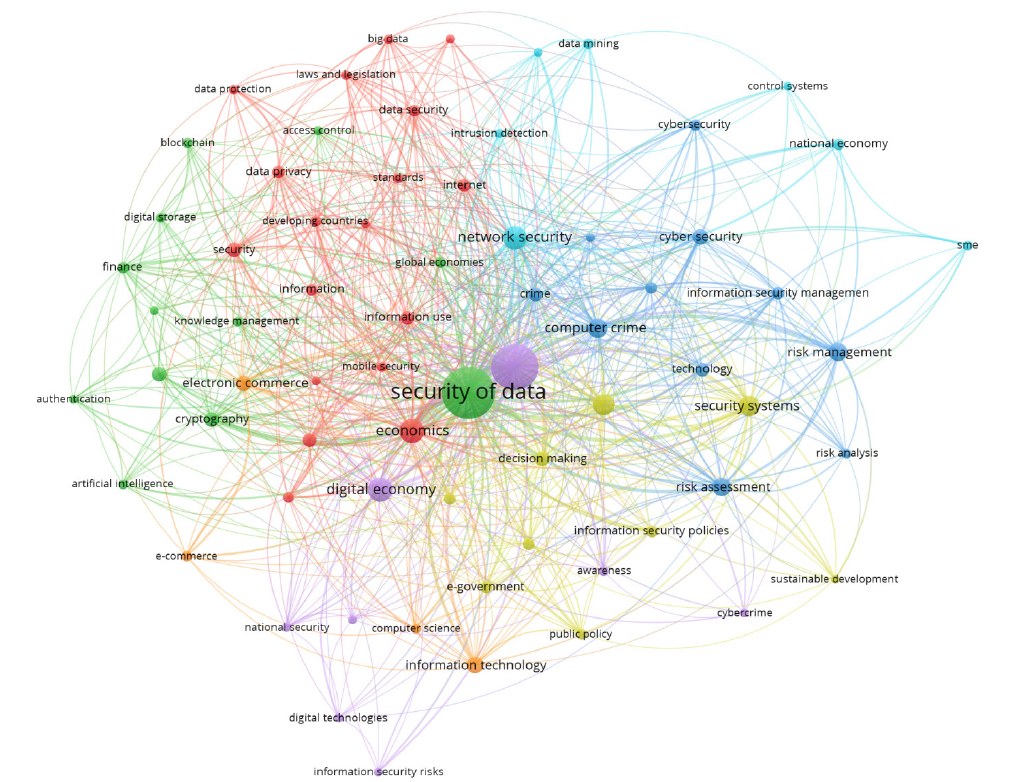
Figure 1. Bibliometric map constructed based on keywords from publications on the Scopus